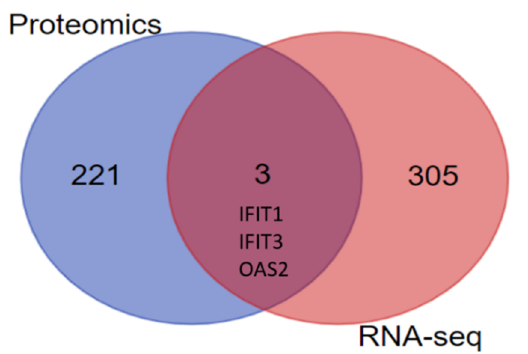
Figure 6. Differentially expressed genes and proteins following E-30 infection of HIBCPP cells . Venn diagram representing differentially expressed genes (308) or differentially abundant proteins (224) following 24 h of infection with E-30 at MOI 20. Among the differentially expressed genes/proteins, IFIT1, IFIT3, and OAS2 were up-regulated in both databases. Genes/proteins with p < 0.05, and a |log2FC| > 1 were considered as differentially expressed ( n = 3).